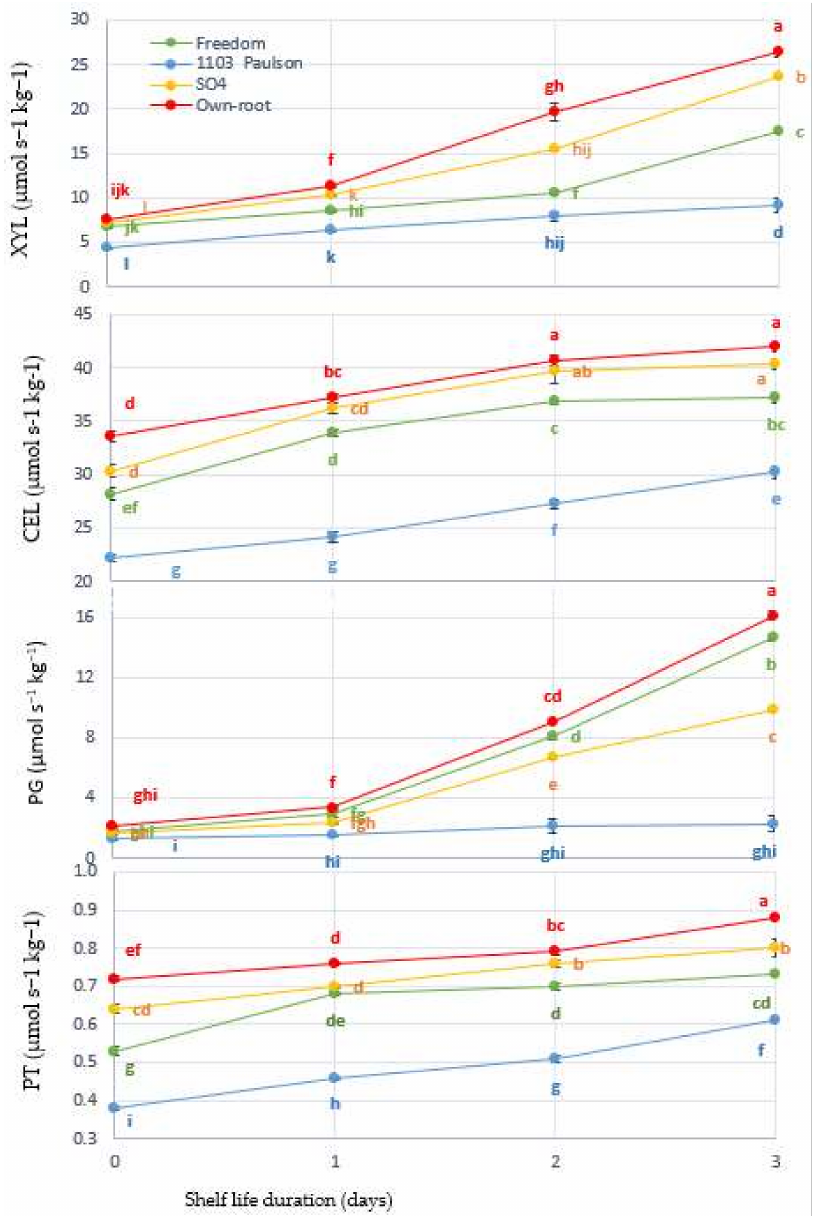
Figure 4. Interaction between Superior Seedless grapevine rootstocks (Freedom, 1103 Paulsen, SO4, and Own Root) and shelf life in days and effect on cellular metabolism enzyme activities such as xylanase (XYL), cellulase (CEL), polygalacturonase (PG), and pectinase (PT) during three days of shelf life (27 ± 1 ◦ C with 57 ± 3% RH). Significantly different samples, according to Tukey’s HSD test at 5%, are indicated by different